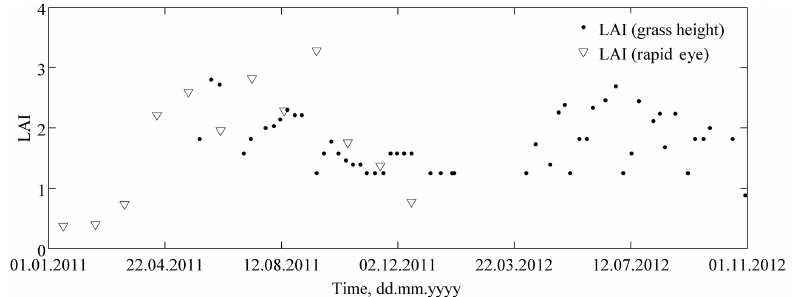
Figure 11. Time series of leaf area index (LAI) computed from measured grass height and extracted from the RapidEye images of the Rollesbroich